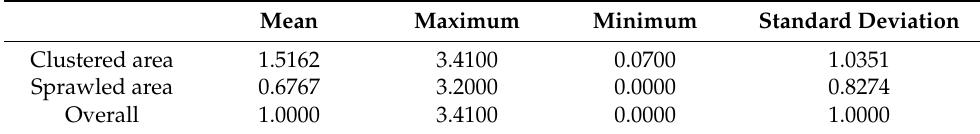
Table 6. The description of PA